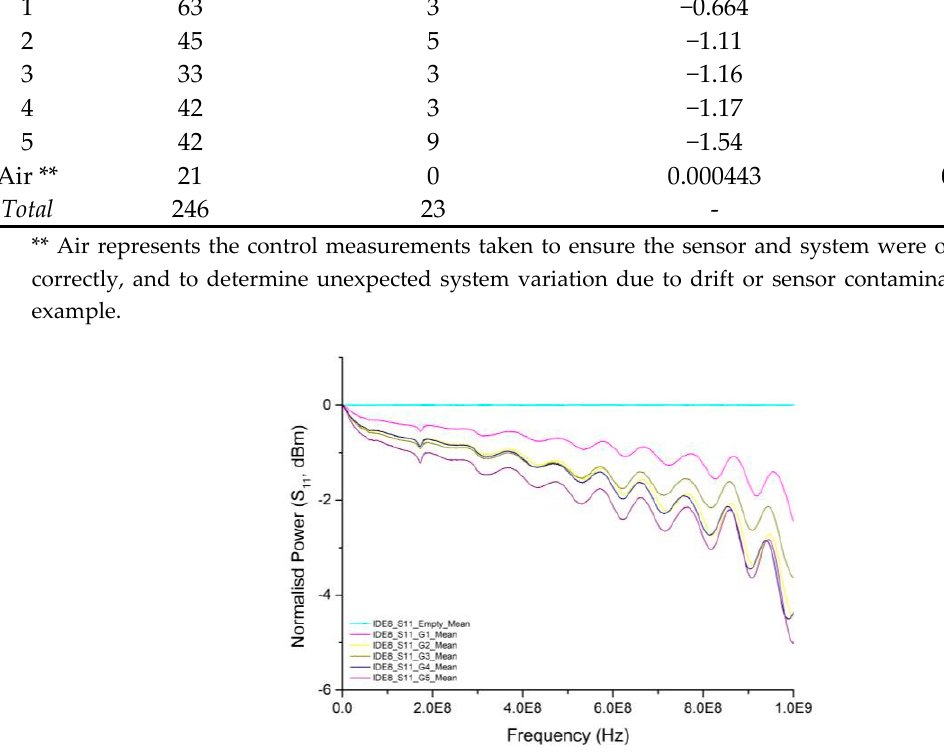
Figure 4. Spectral data between 9 kHz and 1 GHz; observation highlights a clear separation between the spectral data between 200 and 600 MHz.